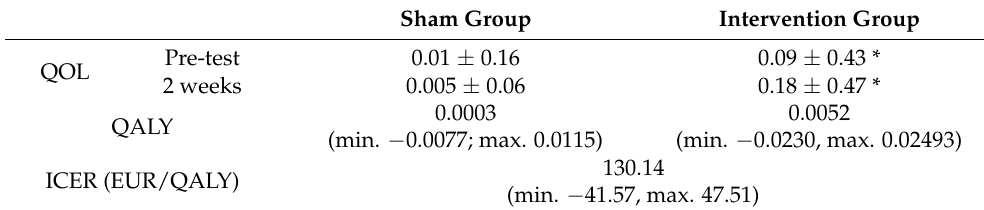
Table 2. QOL, QALY, and ICER.